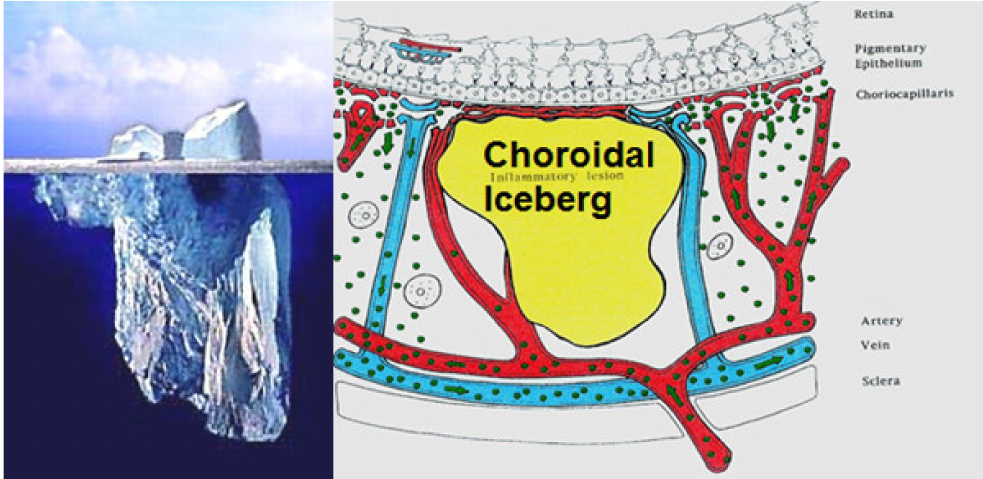
Figure 38. Cartoon of choroidal lesion and the analogic concept of iceberg